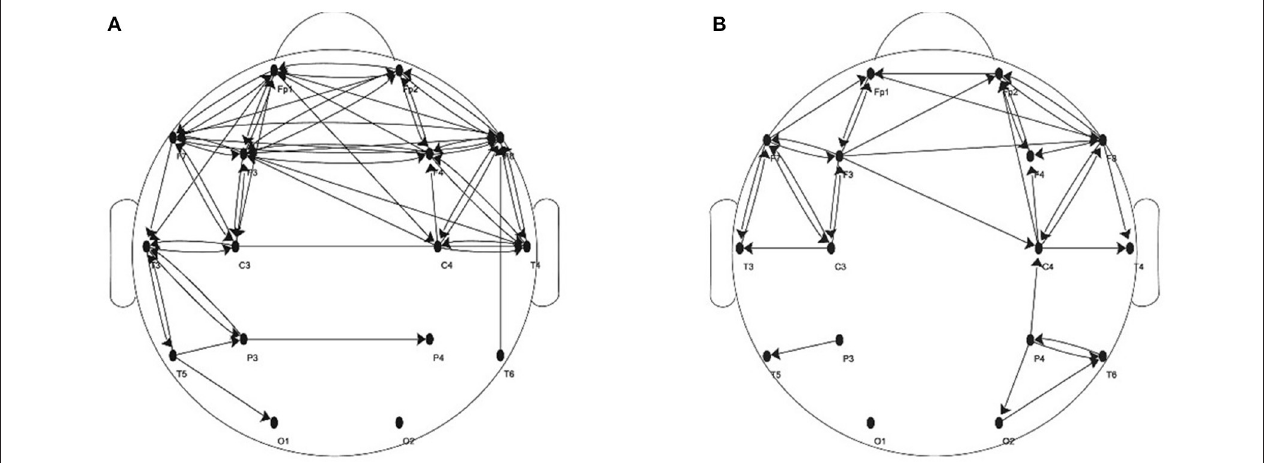
FIGURE 8 | When the threshold is 0.003. (A) Directed binarized network of healthy sample in α rhythm. (B) Directed binarized network of epileptic sample in α rhythm.